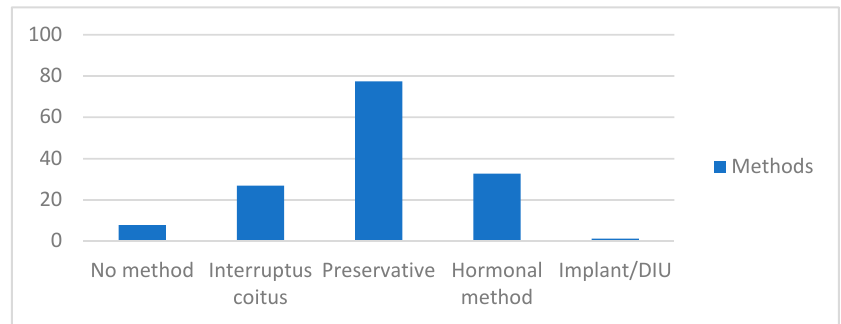
Figure 1. Contraceptive methods used at some point of the sex life (%).